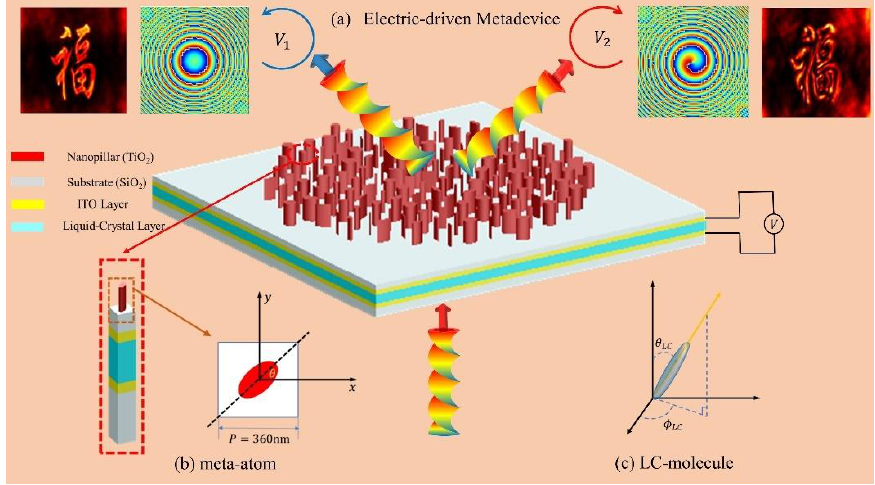
Figure 1. Schematic of the LC-based metadevice. ( a ) The dynamic tunable principle of the metade- vices; ( b ) Schematic of the nano-pillar used in the design of the metasurface; ( c ) Schematic of the LC molecule.